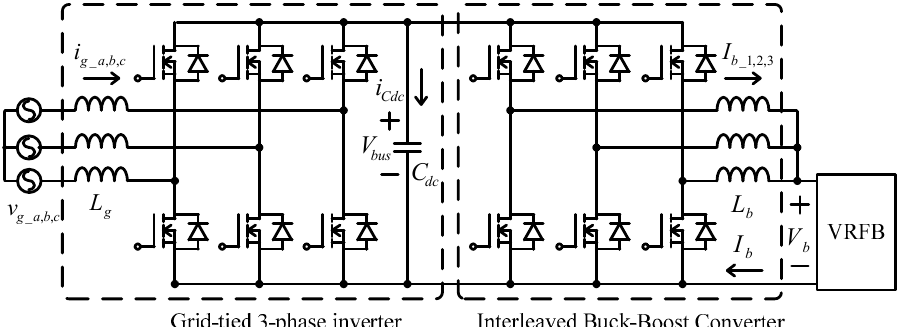
Figure 2. VRFB power conditioning system (PCS) circuit topology.